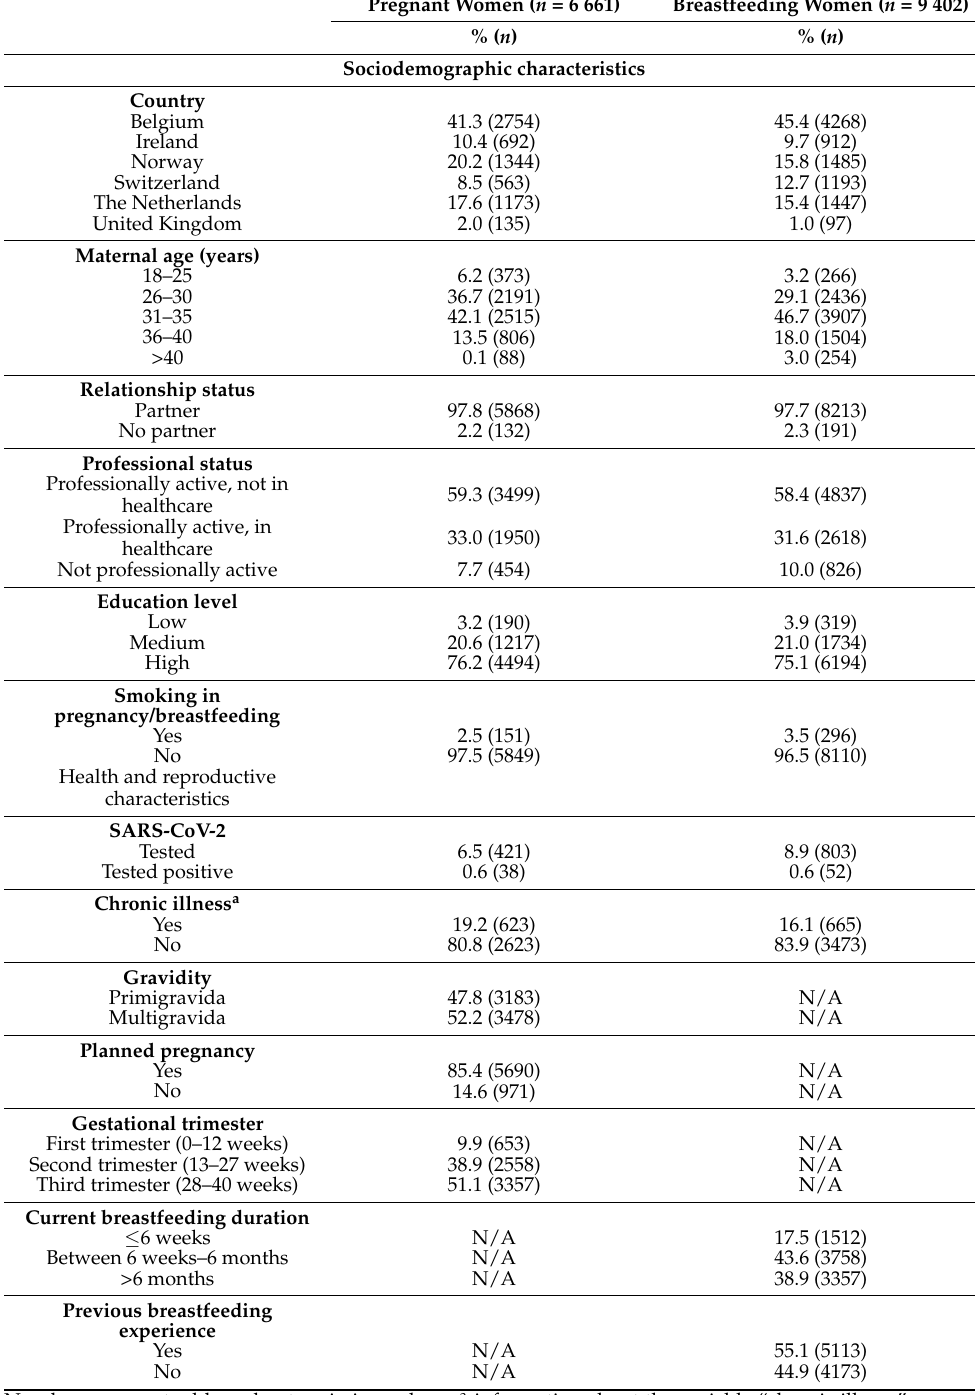
Table 1. Overview of the characteristics of the participants ( n = 16